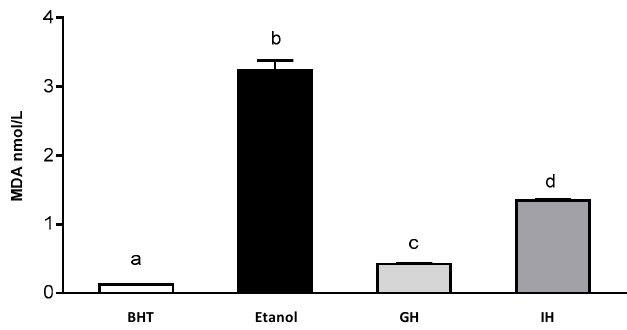
Figure 4. Content of MDA in gastrointestinal hydrolysates from APC. 1.5% ethanol solution, GH (gastric hydrolysate), GIH (gastrointestinal hydrolysate). BHT positive control and ethanol negative control.